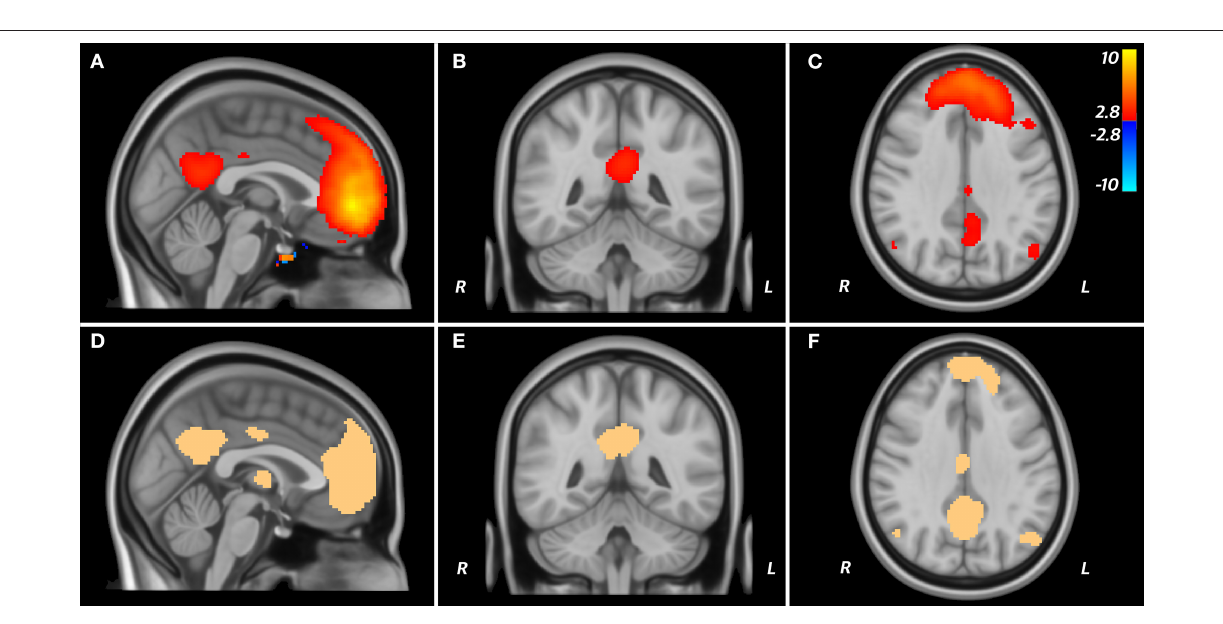
FIGURE 3 | DMN in the Tor-PD connectome. A T map displaying areas functionally connected (T > 2.8; P < 0.001) to the dmPFC when seeded in the Tor-PD connectome (A–C) is shown alongside a mask of the DMN (D–F) . These areas are shown overlaid on sagittal (A,D) , coronal (B,E) , and axial (C,F) slices of a T1-weighted standard brain template (MNI ICBM 2009b NLIN asymmetric). On the T map, “hot” colors represent areas where the BOLD signal is positively correlated with the signal in the seed, while “cold” colors represent ante-correlation. BOLD, blood-oxygen-level-dependent; DMN, default mode network; dmPFC, dorsal medial prefrontal cortex; ICBM, International COnsortium for Brain Mapping; MNI, Montreal Neurological Institute; NLIN,